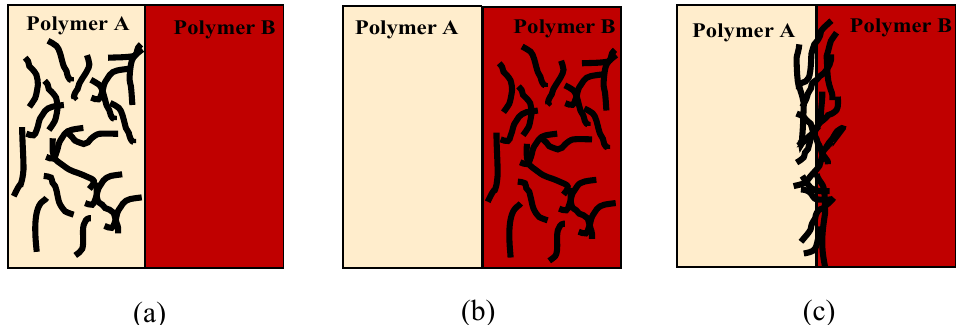
Figure 1. Schematic illustration of carbon nanotube (CNT) selective localization: ( a ) The CNT is completely within Polymer A, ( b ) CNT is fully within Polymer B and ( c ) CNT localizes at the inter- face.